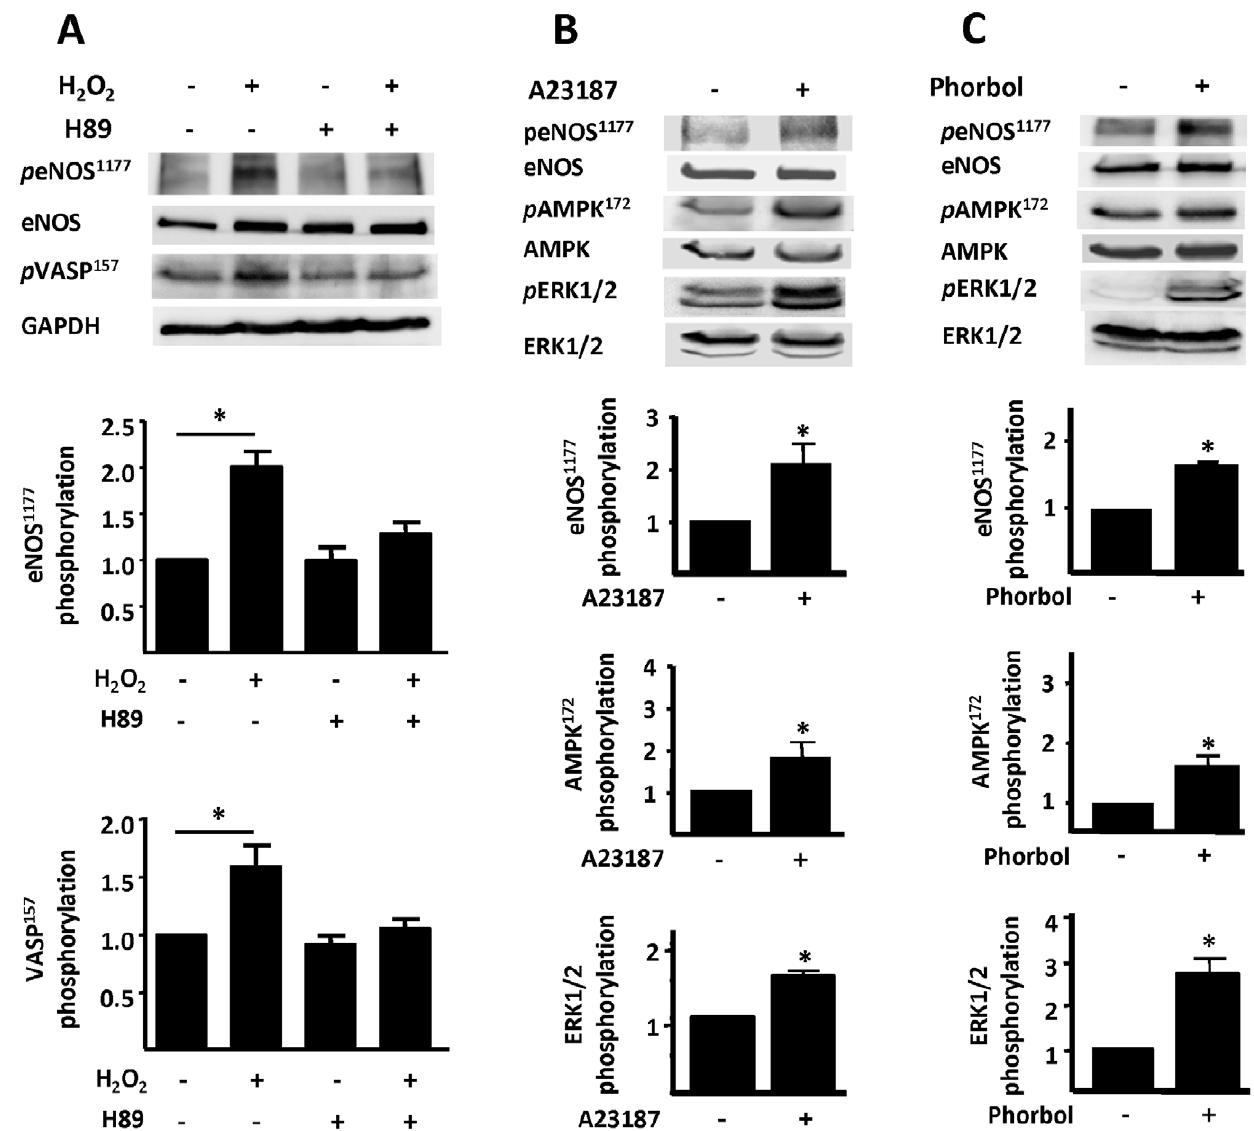
Figure 7. Effect of protein kinase A (PKA) inhibitor on H 2 O 2 -promoted eNOS phosphorylation. In panel A, cardiac myocytes were incubated with H89 (1 m M, 30 min) or vehicle, then treated with H 2 O 2 (25 m M, 15 min) and analyzed in immunoblots probed with antibodies as shown. Below each representative immunoblot are shown the results of densitometric analyses from pooled data, documenting the changes in phospho-eNOS (Ser1177), and phospho-VASP (Ser157) plotted relative to the signals present in unstimulated cells. Each data point represents the mean 6 S.E. derived from at least three independent experiments; *indicates p , 0.05 ( ANOVA ). Panel B shows representative immunoblots from experiments documenting the effects of A23187 (40 m M, 5 min) on cardiac myocyte protein phosphorylation responses. Panel C shows the results of immunoblots analyzed in lysates prepared from cells treated with phorbol 12-myristate 13-acetate (10 m M, 15 min). Cell lysates were analyzed in immunoblots probed with antibodies as indicated. The immunoblot images shown are representative of three independent experiments that yielded similar results. Below each immunoblot panel are the results of densitometric analyses from pooled data, showing the fold increase in protein phosphorylation (in arbitrary units), *indicates p , 0.05.